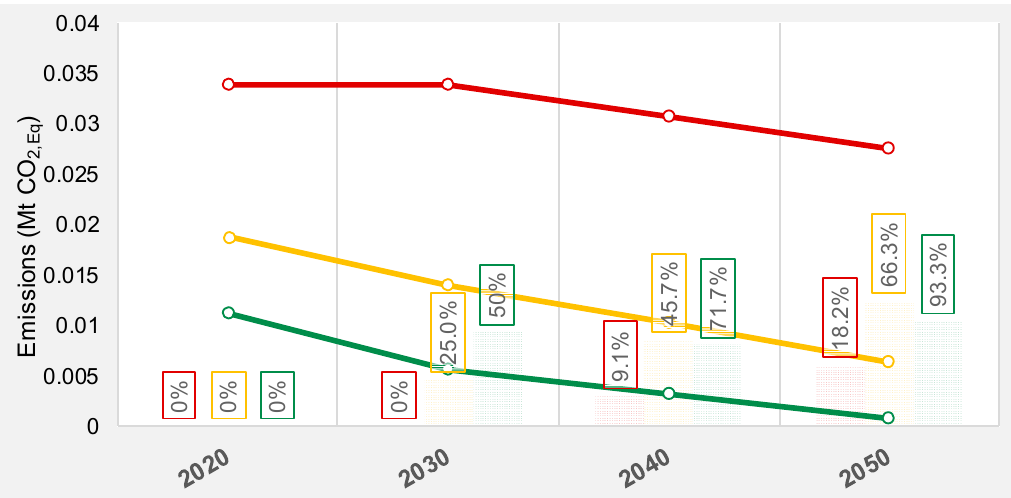
Figure 16. Calculation of GHG emissions (lines) and reduction compared to 2020 (bars) for botanicals manufacturing in Germany. Three process improvement scenarios are considered: red = worst case (low impact and slow industrialization); orange = realistic (impact as discussed, normal industrialization time) and green = best case (highest impact and fast industrialization).